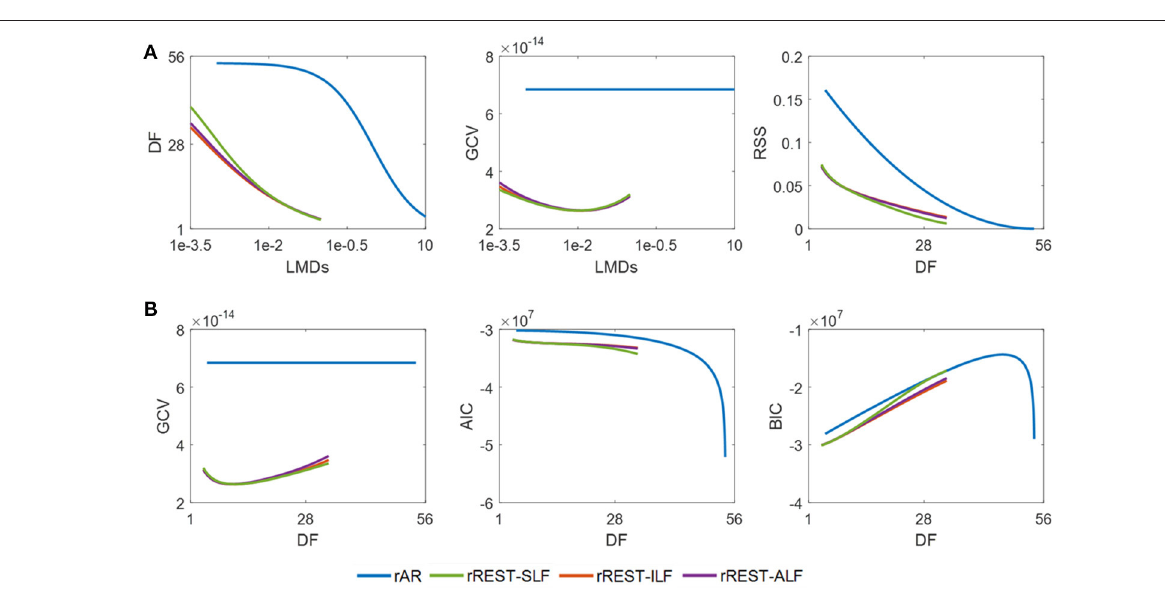
FIGURE 8 | Model selection with actual EEG. DF, RSS, GCV, AIC, and BIC are the average of them individually explored over the 89 real EEG recordings. (A) DF and GCV against LMD, and RSS varying with DF; (B) , model selection criteria (GCV, AIC, and BIC) against DF. DF, degree of freedom; RSS, residual sum square; GCV, generalized cross validation; AIC, Akaike information criteria; BIC, Bayesian information criteria; SLF, spherical lead field; ILF, individual realistic lead field; ALF, the average of realistic lead fields; sILF, sparse individual lead